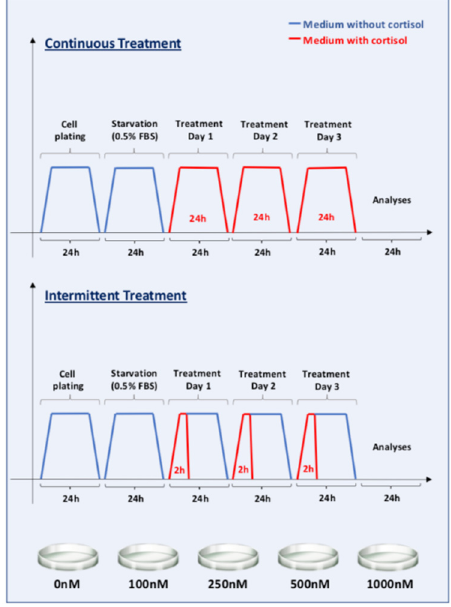
Figure 1. Study design. The first trimester extravillous trophoblast cell line SGHPL-4 was divided into 2 main groups: “continuous” and “intermittent” exposure to cortisol. Each of these groups was divided into another 5 groups according to the cortisol dose (0, 100, 250, 500, or 1000 nM). The cells were plated on the first day, and the next day, the medium was replaced with one with only 0.5% FBS (fasting). After 24 h starvation, the cells were treated with cortisol (a ready-to-use solution prepared in 100% methanol) in the culture medium, and the control cells were supplemented with the same volume of methanol (vehicle). Continuous exposure groups received the cortisol doses 24 h/day, for 3 days, and intermittent exposure groups received cortisol in the culture medium for 2 h/day, also for 3 days. The culture medium was changed daily.